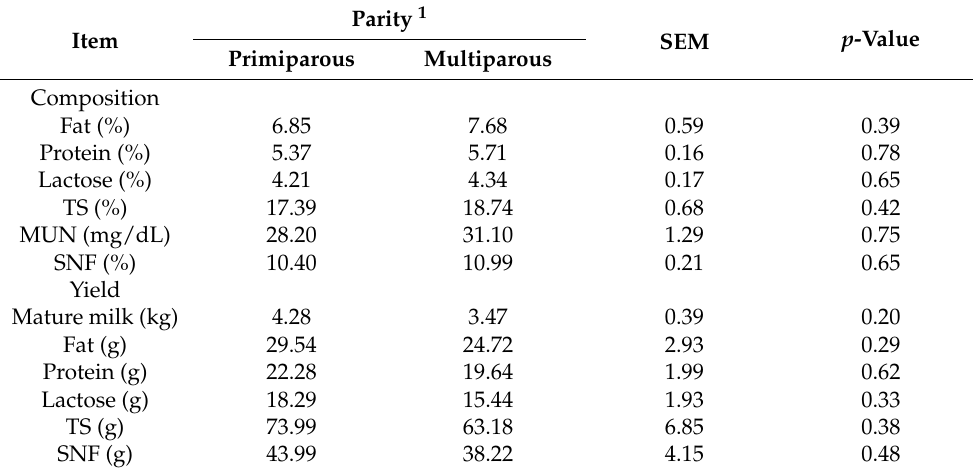
Table 2. Differences of mature milk composition and yields between primiparous (n = 10) and multiparous (n = 10) buffaloes.